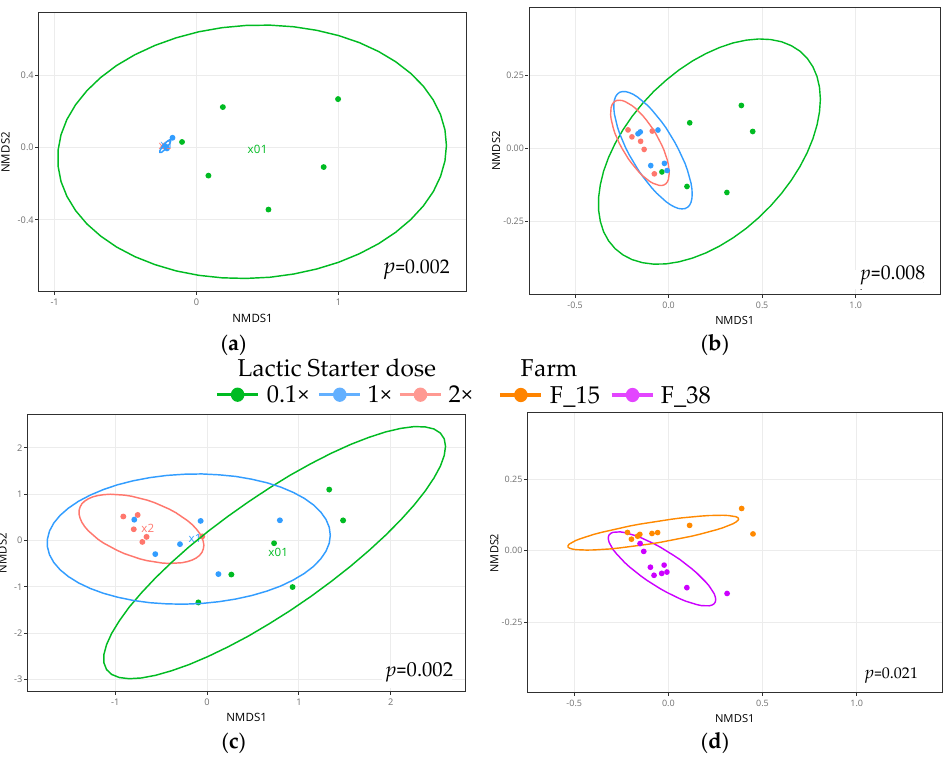
Figure 4. Beta-diversity of ( a ) Cheese core samples at D8 ( n = 18), ( b ) Cheese core samples at D28 ( n = 18), and ( c ) Cheese rind samples at D28 ( n = 18) clustered according to the lactic starter dose; and ( d ) Cheese core samples at D28 ( n = 18) clustered according to the farm. Non-Metric multidimensional scaling (NMDS) based on the Bray Curtis algorithm of bacterial communities. p -value was obtained after permutational MANOVA analysis (Adonis statistical test) and indicates significance between sample groups.